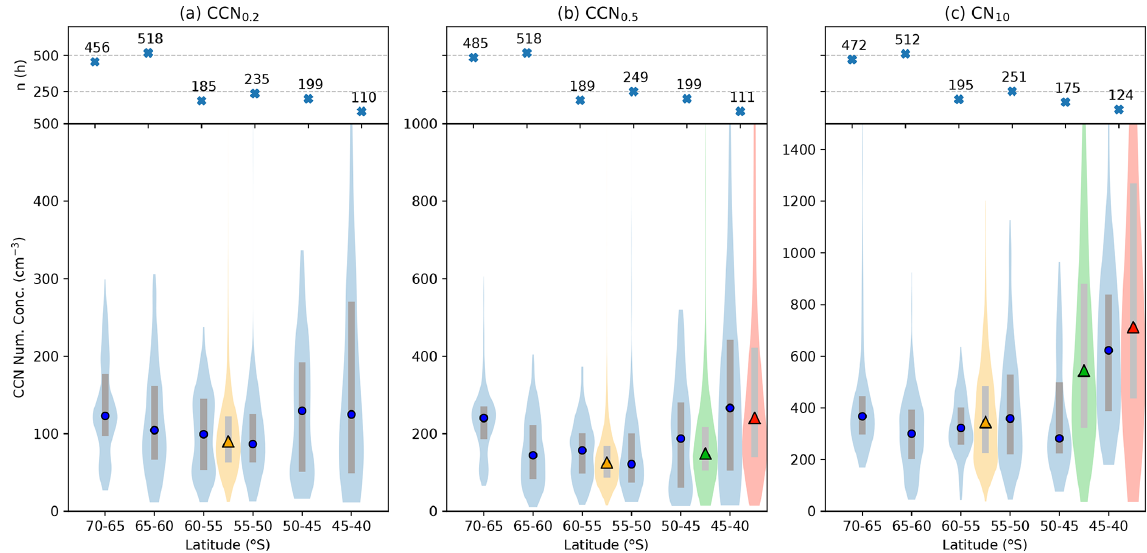
Figure 2. Latitudinal distributions of CCN (at (a) 0.2% and (b) 0.5% supersaturation) and CN 10 (c) from collated data from both MARCUS and CAPRICORN2 campaigns shown in blue. Data are binned into 5 ◦ latitudinal bins and plotted as violin plots with medians (circles) and 25th and 75th percentiles (grey box) shown. Data from November 2017 to March 2018 from Macquarie Island (54 ◦ 30 (cid:48) S, 158 ◦ 57 (cid:48) E; orange) and Cape Grim (40 ◦ 39 (cid:48) S, 144 ◦ 44 (cid:48) E; left, green is baseline (Rn < 100mBq, wind directions between 190 and 280 ◦ ); red is all data) at their respective latitudinal bins. Subplots above each plot show the number of hourly data points in each bin. Note the y -axis scales are custom for each